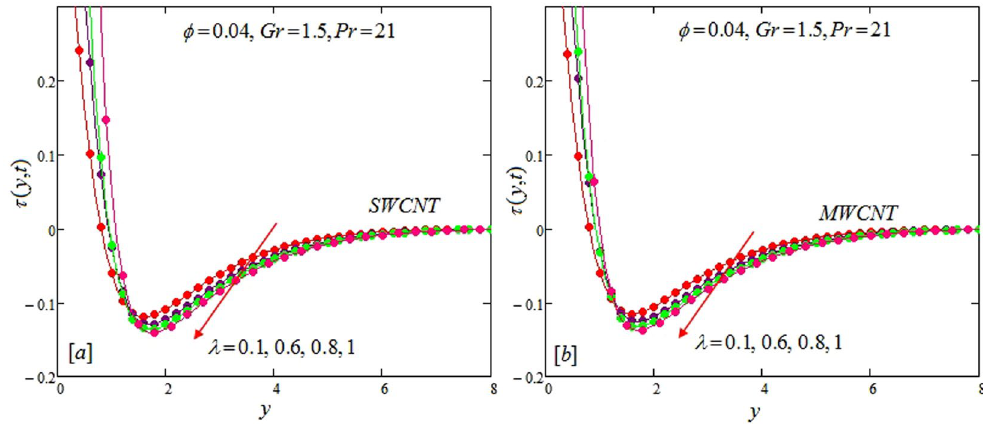
Figure 9. Shear stress profiles for single and multiple wall CNTs for different values of Maxwell parameter.